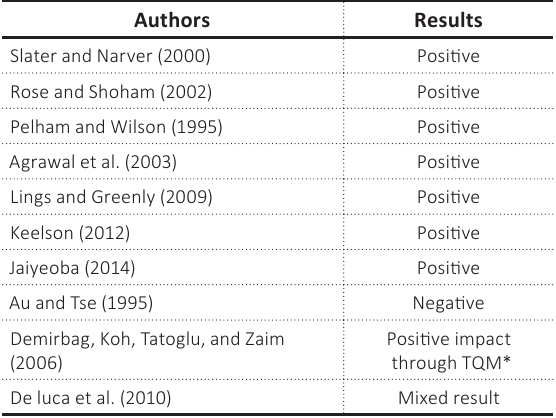
Table 1. The results of some empirical